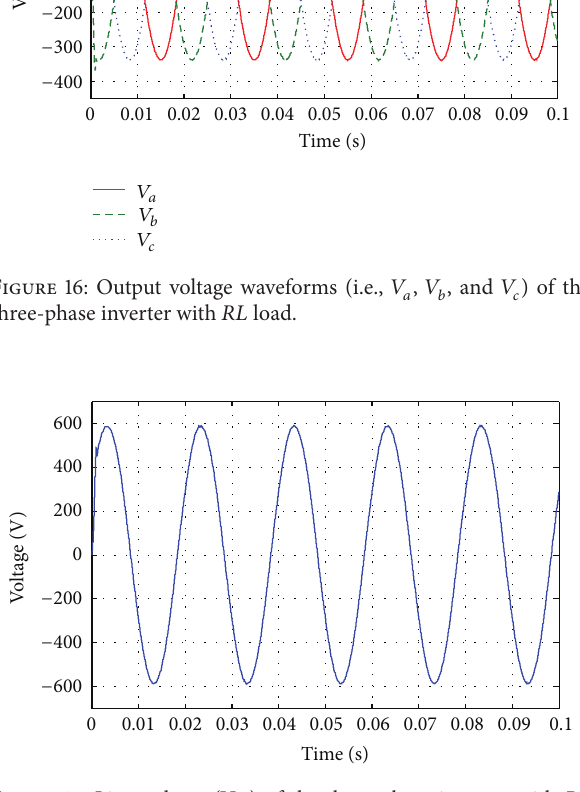
Figure 17: Line voltage ( 𝑉 𝑎𝑏 ) of the three-phase inverter with 𝑅𝐿 load.